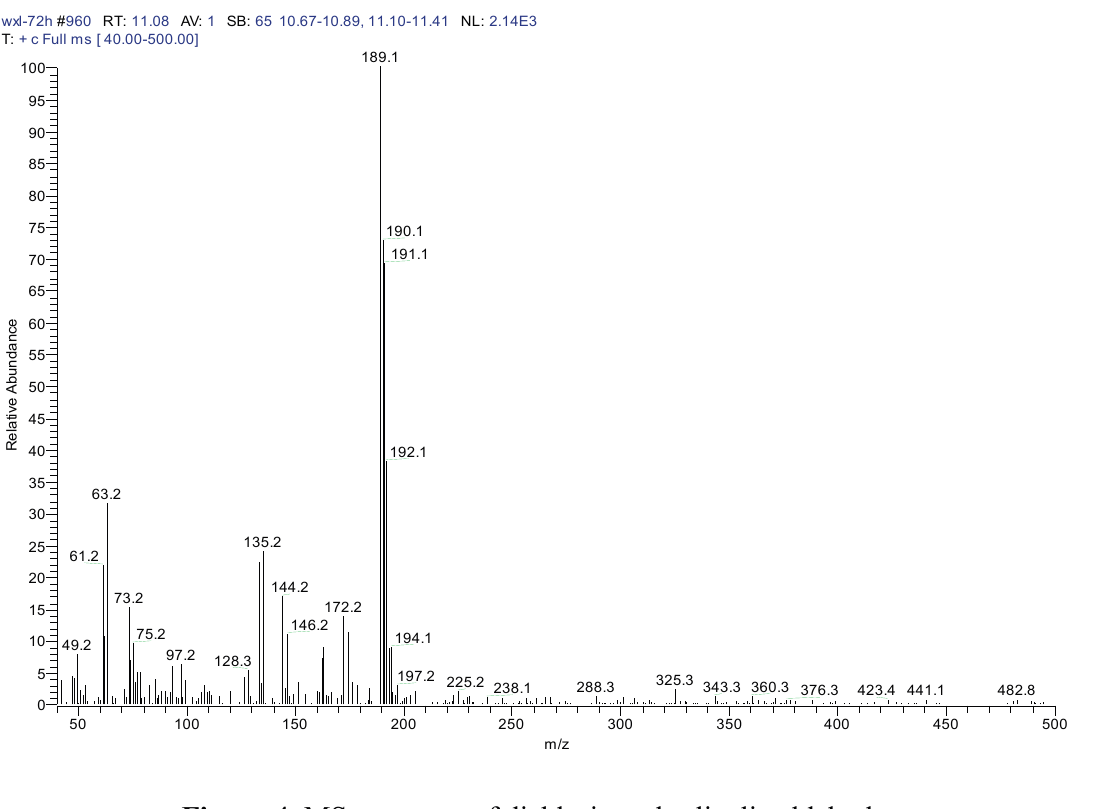
Figure 4. MS spectrum of dichlorinated salicylic aldehyde.